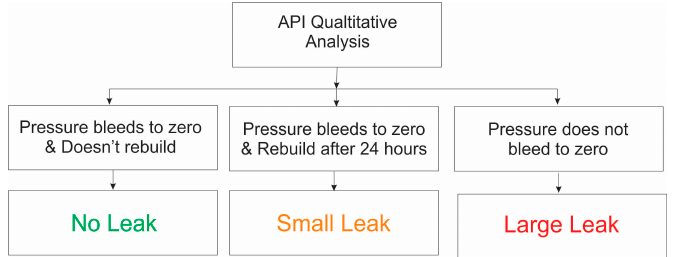
Figure 2. API qualitative analysis of leak size in wells with SCP (adapted with permission from Kazemi et al., SPE, 2014).